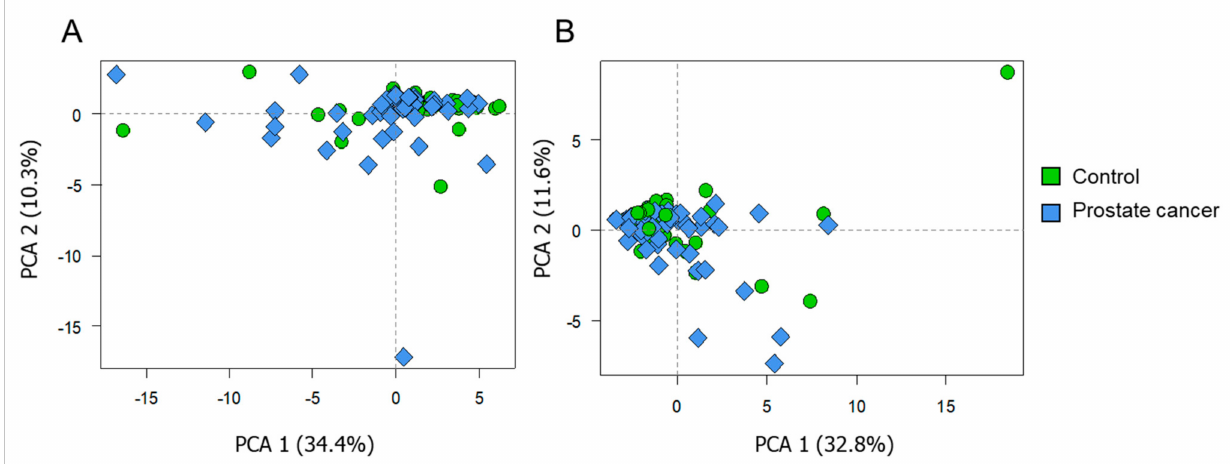
Figure 3. PCA score plots built on the data from ESI-QqQ/MS ( A ) and MALDI-ToF/MS ( B ) analysis. Diamonds and circles correspond to the profiles belonging to the PCa patients and control group,